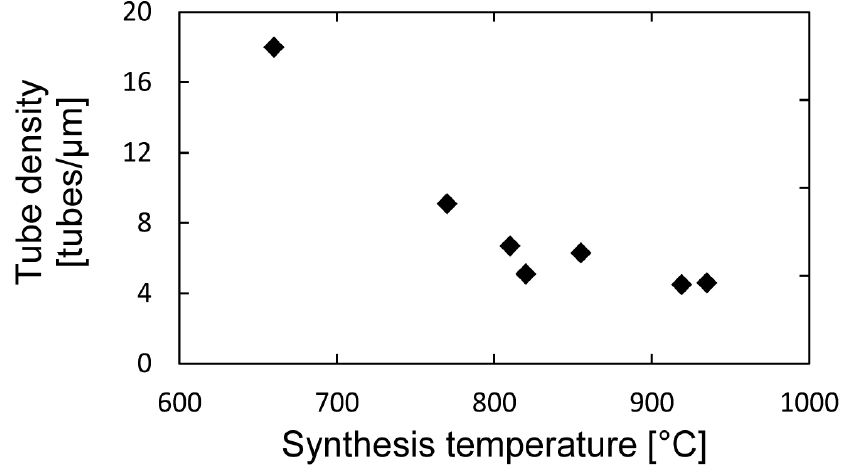
Figure 6. Growth density of randomly oriented CNTs on the microheater surface as a function of synthesis